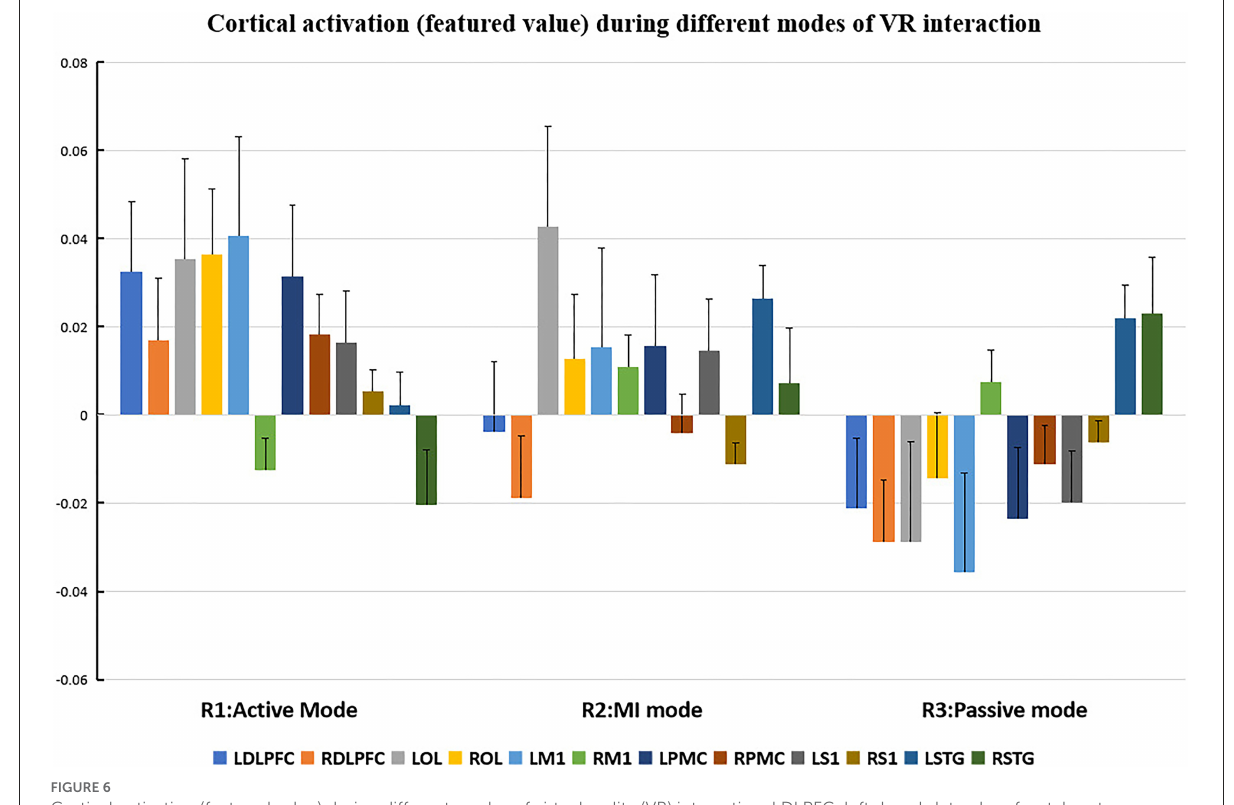
FIGURE6 Cortical activation (featured value) during different modes of virtual reality (VR) interaction. LDLPFC: left dorsal–lateral prefrontal cortex; RDLPFC, right dorsal–lateral prefrontal cortex; LOL, left occipital lobe; ROL, right occipital lobe; LM1, left primary motor cortex; RM1, right primary motor cortex; LPMC, left premotor cortex; RPMC, right premotor cortex; LS1, left primary somatosensory cortex; RS1, right primary somatosensory cortex; LSTG, left superior temporal gyrus; RSTG: right superior temporal